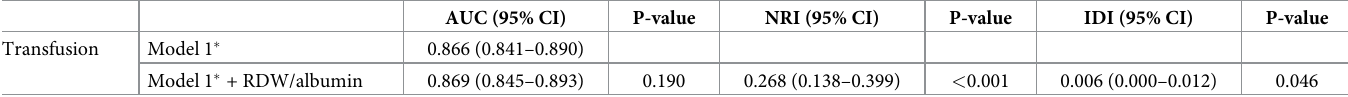
Table 3. Improvement in AUC and NRI by addition of RDW/albumin to clinical predictive models.